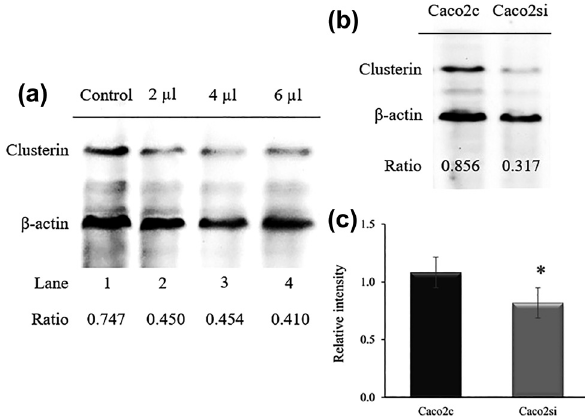
Figure 1: Silencing clusterin mRNA in Caco2. (A) Optimisation of the transfection reagent for clusterin mRNA silencing, whereby 0 (control), 2, 4, and 6 µl of reagents were used for the optimisation. (B) The ef fi cacy of clusterin mRNA silencing at the protein expression level in Caco2 by Western blotting. (C) The ef fi cacyof CLUgenesilencing